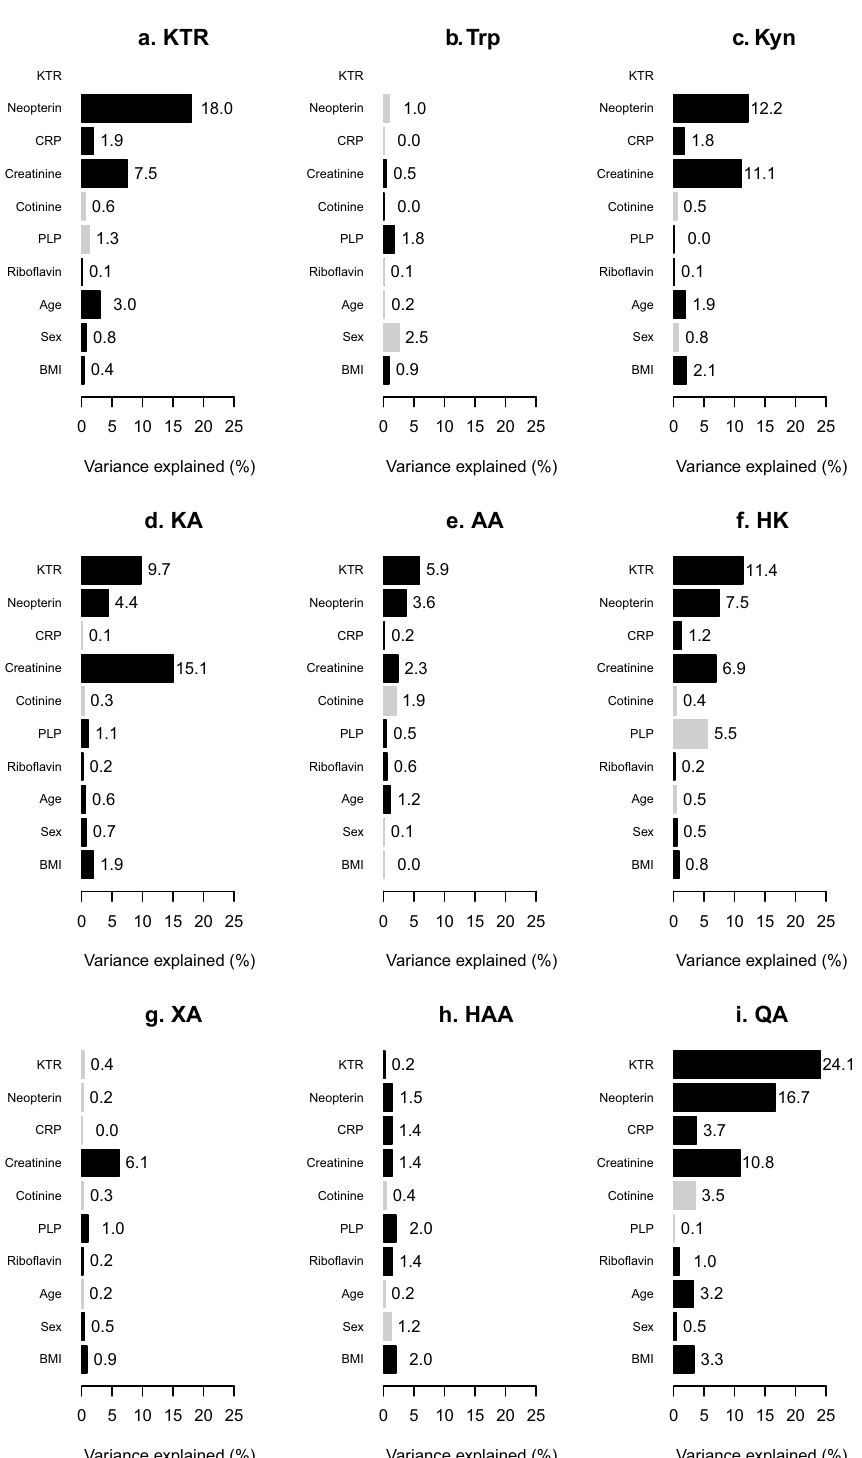
Figure 3. Relative importance of predictors of kynurenines. The percentage of variance of tryptophan and kynurenines explained by regression models using relaimpo. All continuous variables were log-transformed and then centered on the mean and standardized by dividing by the standard deviation. Black bars are used for predictors that showed positive regression coefficients in the mixed models (Table 2), those with negative coefficients are shown in grey. KTR and neopterin were included in separate models, and the models were adjusted for cohorts. AA: anthranilic acid; BMI: body mass index; CRP: C-reactive protein;